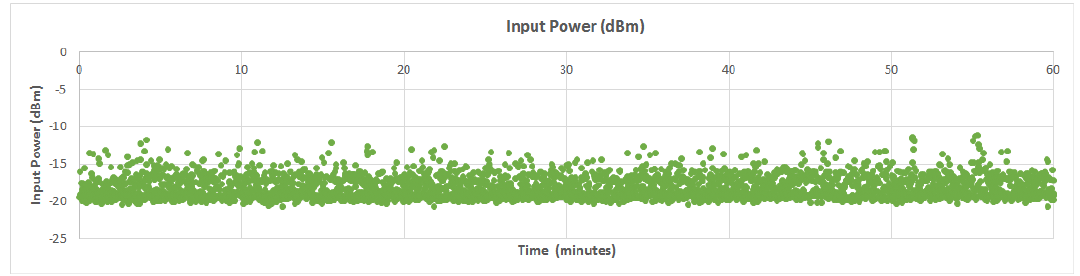
Figure 20. Input power as measured for 1